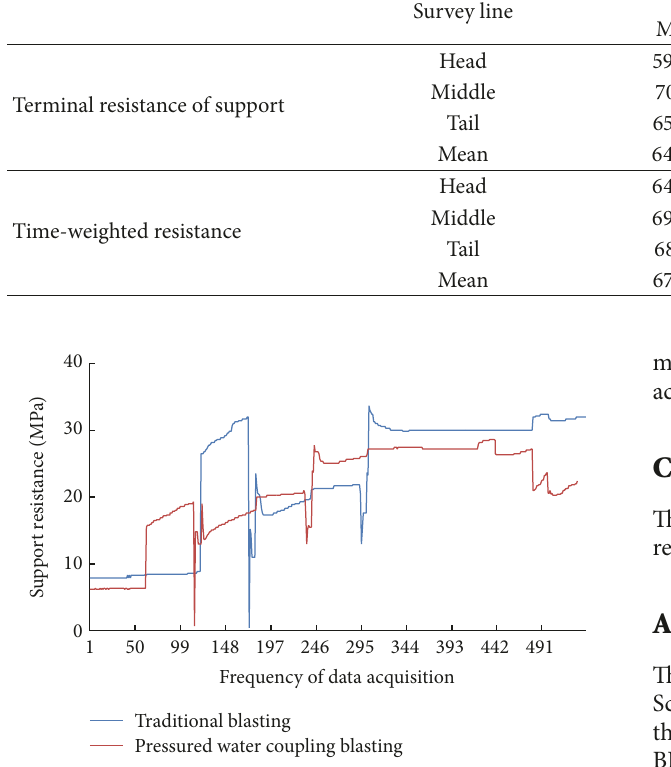
Figure 16: Stress acting on supports in the two blasting